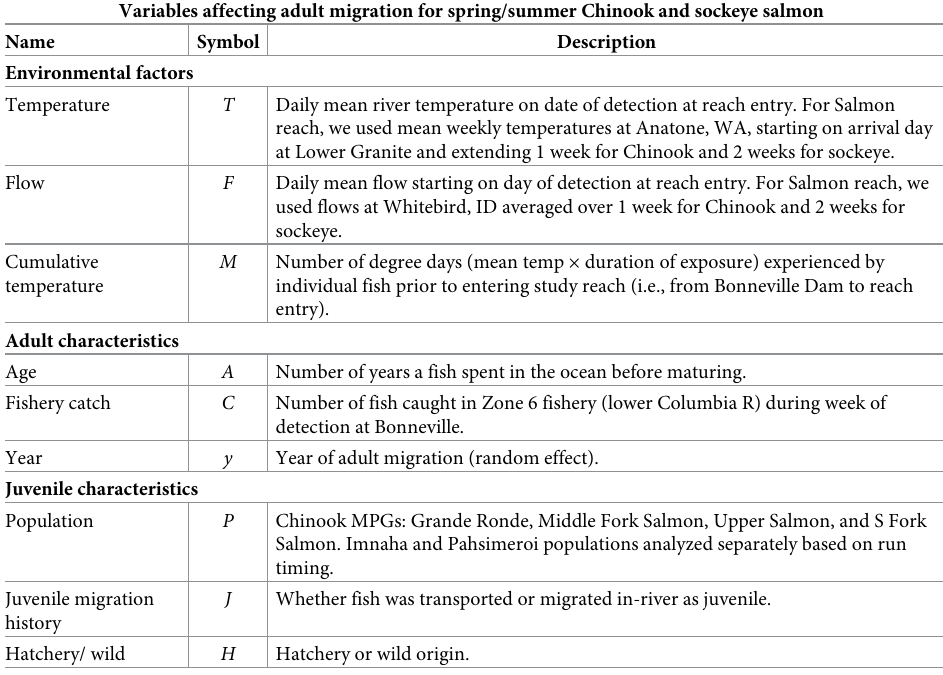
Table 2. Variables used in upstream migration survival